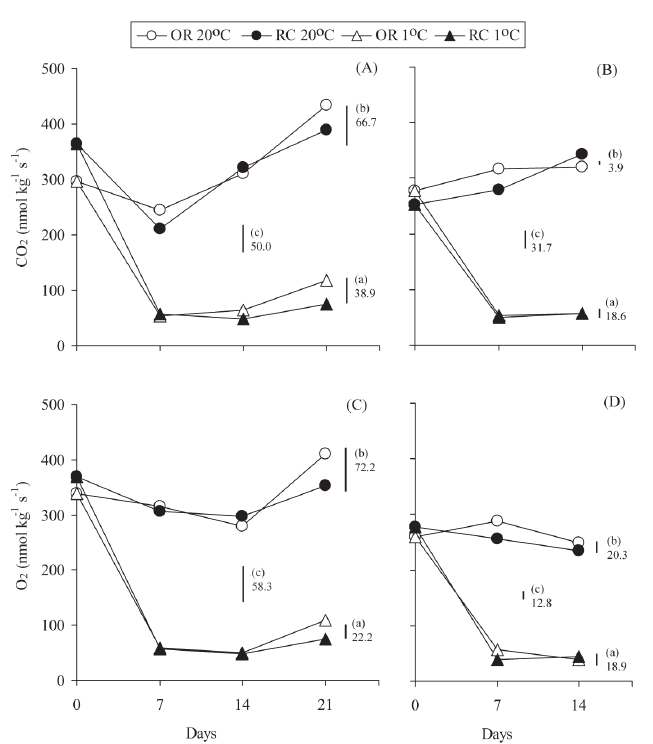
Fig. 1: Effects of rain cover on respiration rates in ‘Adriana’ in 2009 and ‘Noire de Meched’ cherries in 2011 before, during and after storage. (A) and (B), CO 2 production rates; (C) and (D), O 2 uptake rates; (A) and (C), ‘Adriana’; (B) and (D), ‘Noire de Meched’. OR, Orchard Uncovered; RC, Rain Covered Orchard. Vertical bars correspond to LSD at a = 0.05. (a) bars, 1 o C, including data at harvest; (b) bars, 20 o C, including data at harvest; (c) bars, all data apart from those at harvest.